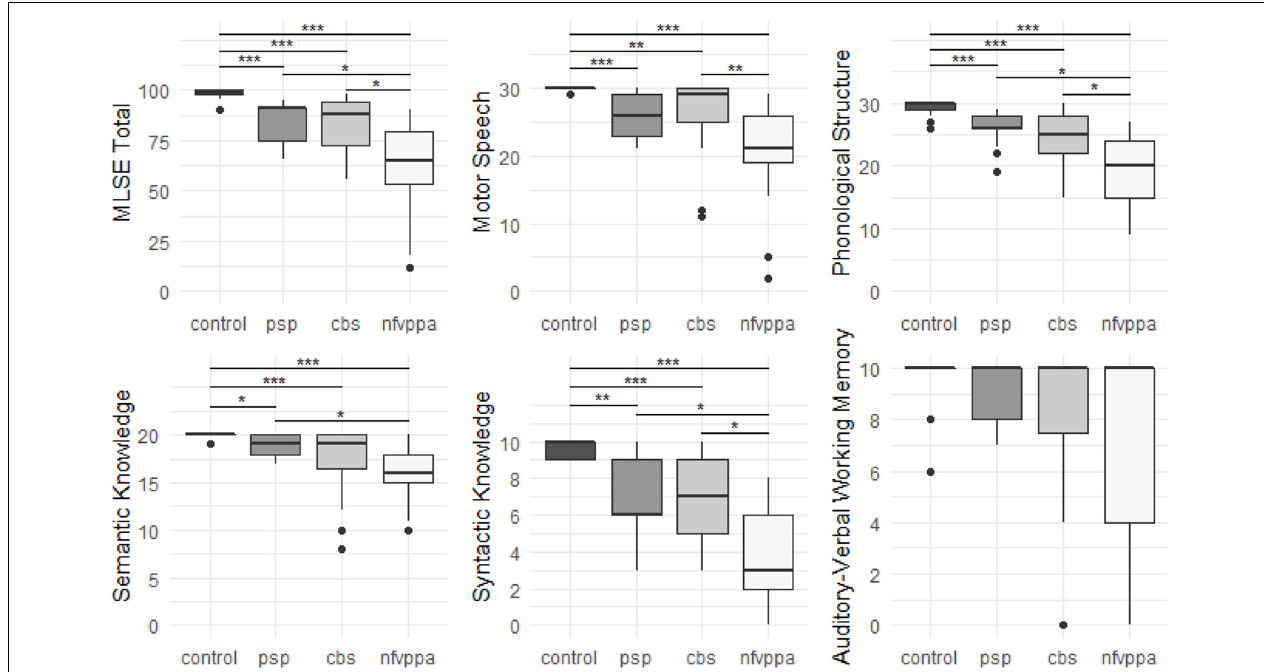
FIGURE 1 | Boxplots of group MLSE total and domain scores. The y-axes for each plot span the min to max scores. Significance markers represent adjusted p values from post hoc pairwise comparisons using the Dunn test with Benjamini-Hochberg adjustment. “***” = adjusted p value < 0.001, “**” = adjusted p value < 0.01, “*” = adjusted p value <